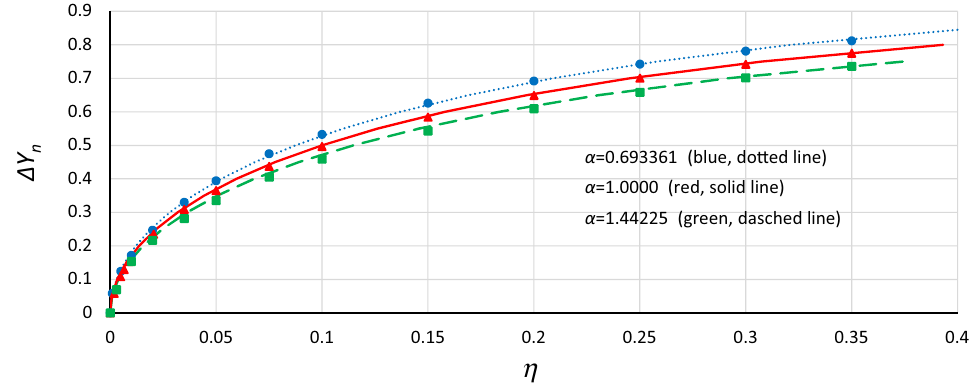
Figure 16. Comparison of the Y n displacement of the origin point P B due to damping obtained from numerical simulations (markers) and on the basis of formula (15) (curves).